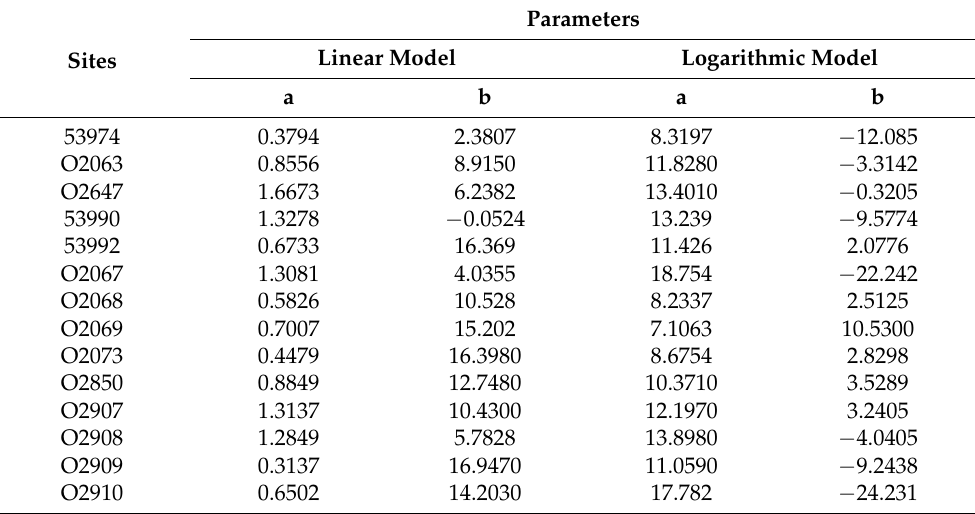
Table 3. The parameters of linear model and logarithmic